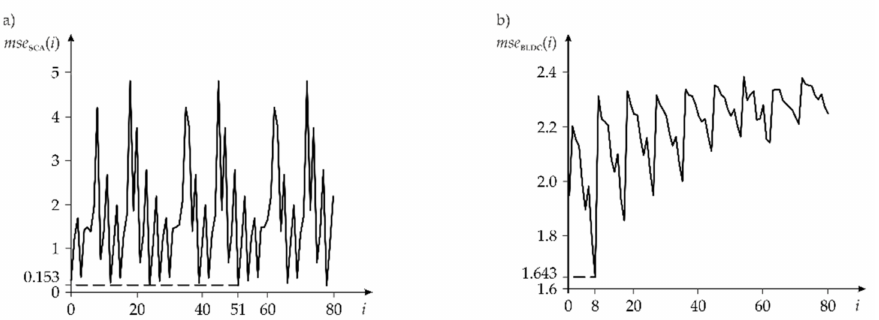
Figure 10. Characteristics of the mse for the considered machines: ( a ) SCA; ( b ) BLDC. The minimum values of the mse were obtained for i equal to 51 and 8, respectively, for both